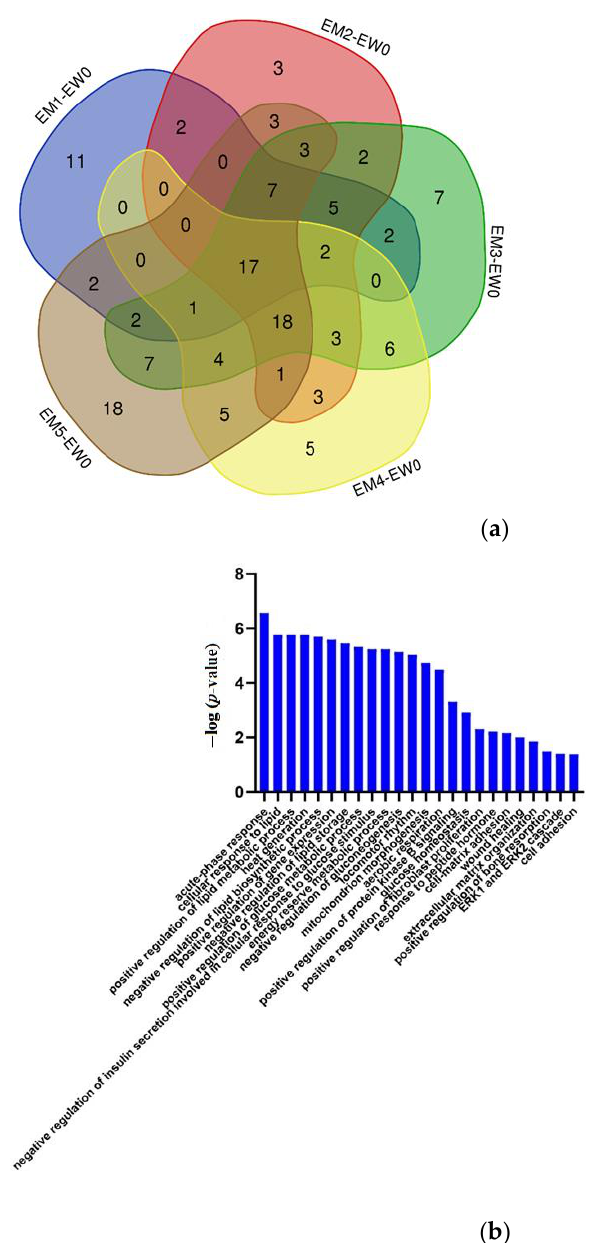
Figure 4. Differential proteins in the whole process. ( a ) Venn diagram of differential proteins among the other time points (M1/M2/M3/M4/M5) and week 0 samples in the experimental group. ( b ) Biological processes enriched by continuously changing proteins in the comparison within the experimental group ( p < 0.05).